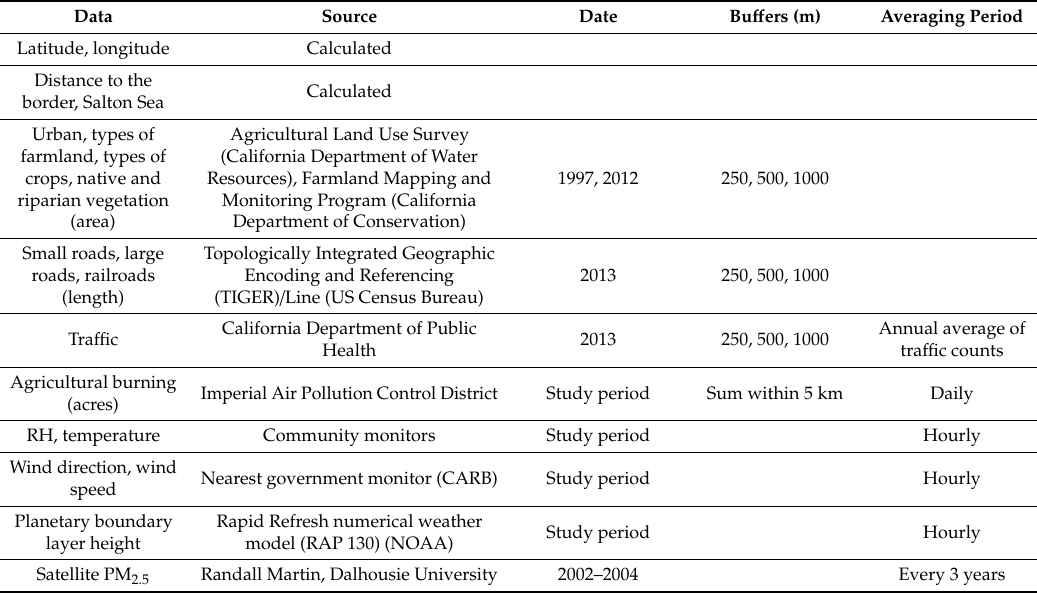
Table 1. Model variables. RH—relative humidity; PM 2.5 —particulate matter less than 2.5 µ m in diameter; US—United states; CARB—California Air Resources